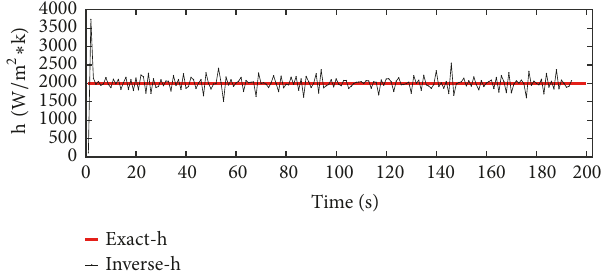
Figure 11: The heat transfer coefficient of the measuring point with 𝜎 = 0.005 .